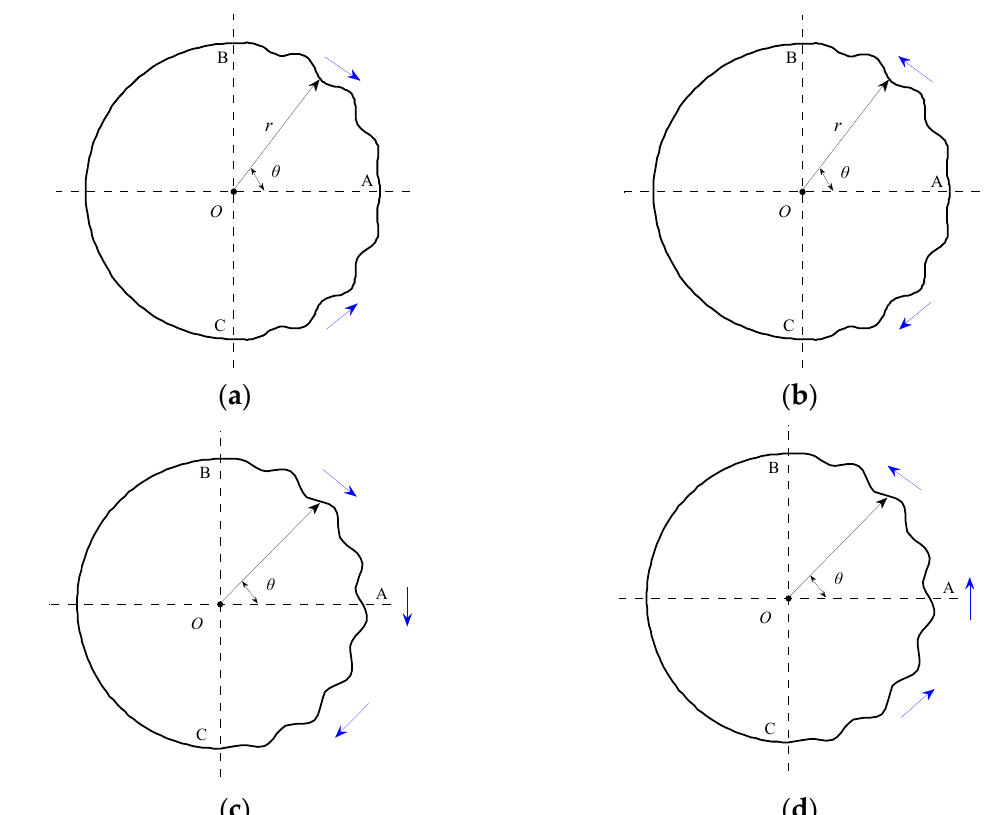
Figure 4. Four types of propagation direction of TWW. ( a ) Downstream. ( b ) Upstream. ( c ) Corotating-Clockwise. ( d ) Corotating-Counterclockwise.